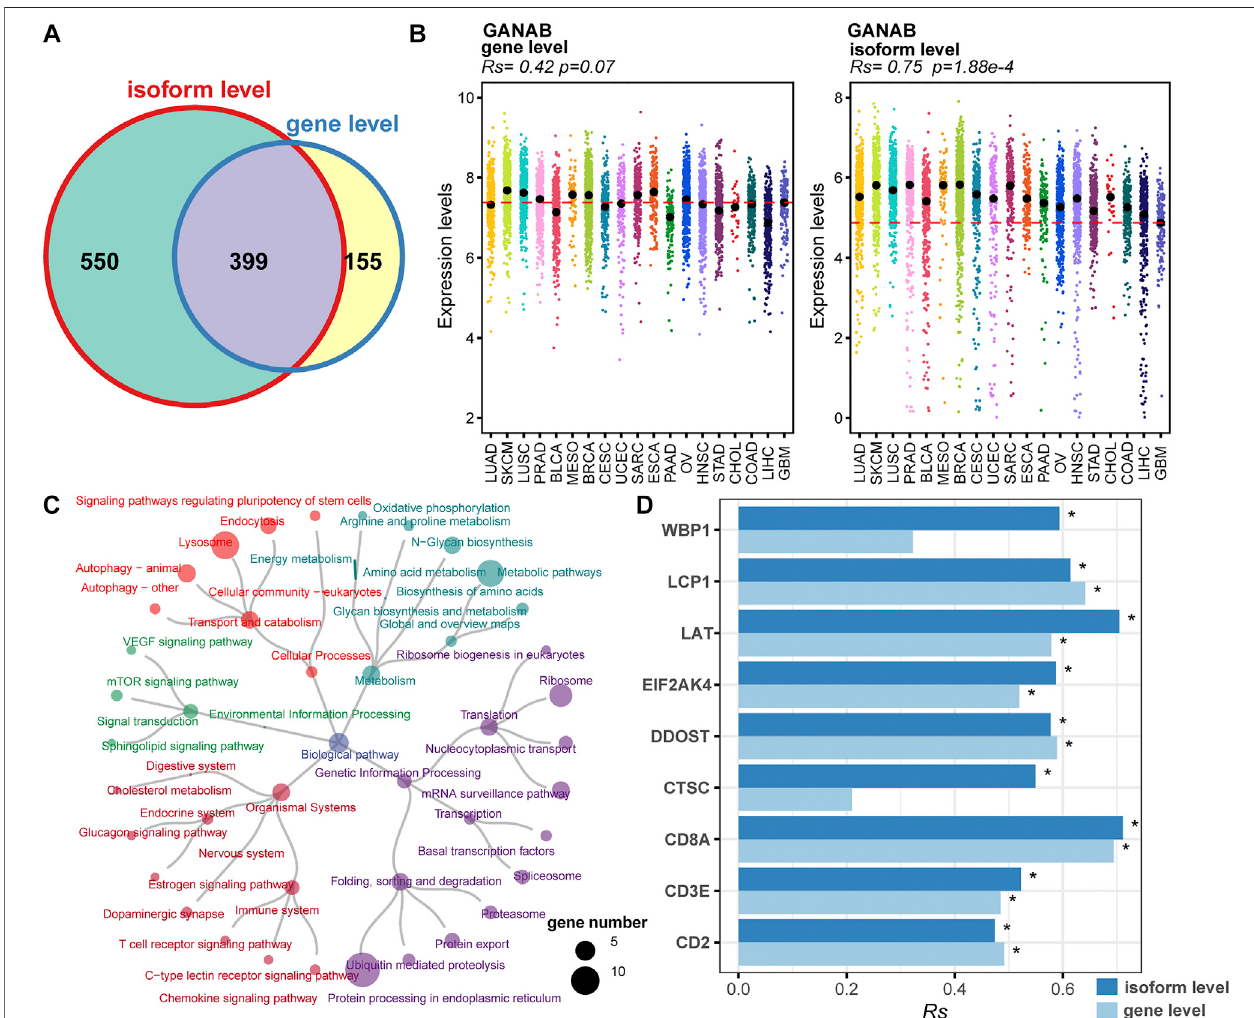
FIGURE 3 | Identi fi cation of irAEs-related splicing isoforms. (A) Venn plot of irAEs-related genes identi fi ed on gene- and isoform-level, respectively. (B) Spearman correlation between irAEROR and GANAB expressionongeneand isoform level. Rs and the corresponding p value are shown at the top-leftofthe fi gure. Strip plots show expression distribution of GANAB on gene (left) and isoform level (right) . Each column represents a cancer type. Each dot corresponds to log 2 (TPM+0.001) transformed expression value of the selected gene in one sample on gene- and isoform-level, respectively. The dashed lines display the median of GANAB expression in GBM on gene- and isoform-level, respectively. (C) Pathway enrichment analysis for positive correlated splicing isoforms to irAE. The pathways are colored according to pathway hierarchy. The number of parental genes is shown by dot size. (D) Spearman correlation between irAE ROR and splicing isoforms involved in T cell activation and T cell- mediated cytotoxicity. * indicates signi fi cant correlation ( p value < 0.05). The bar represents Rs , whereas the color indicates Rs is calculated at gene or isoform level.